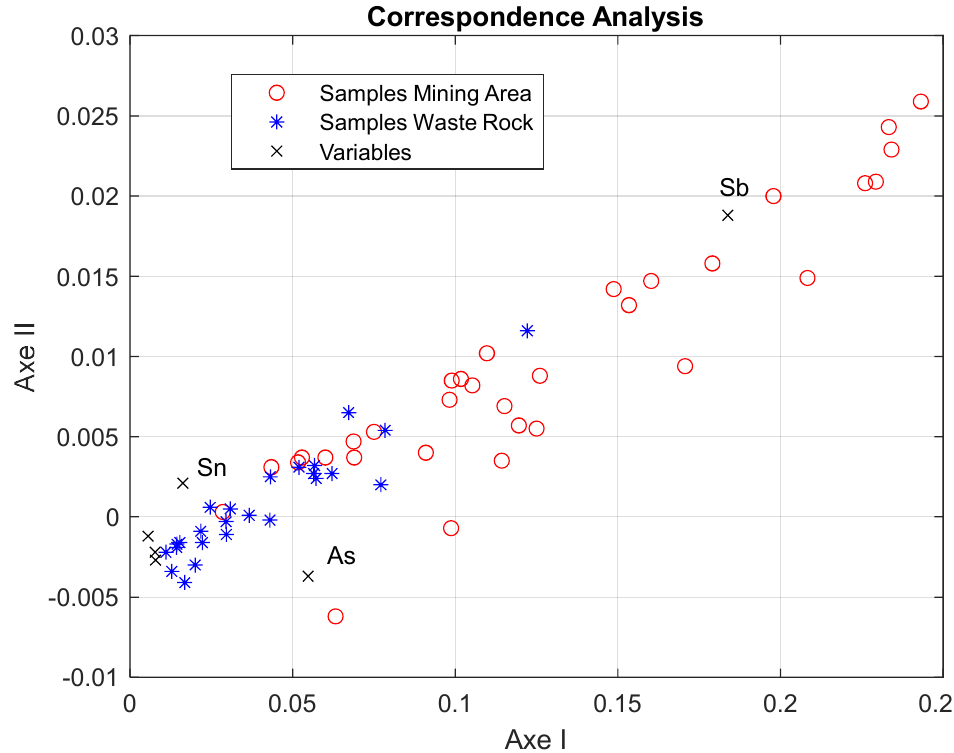
Figure 10. Plots of samples and chemical elements in the same metric using correspondence analy- sis.